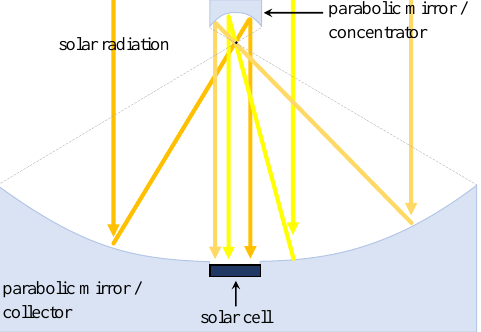
Figure 6. Parabolic mirror concentrator without optical lenses [50].